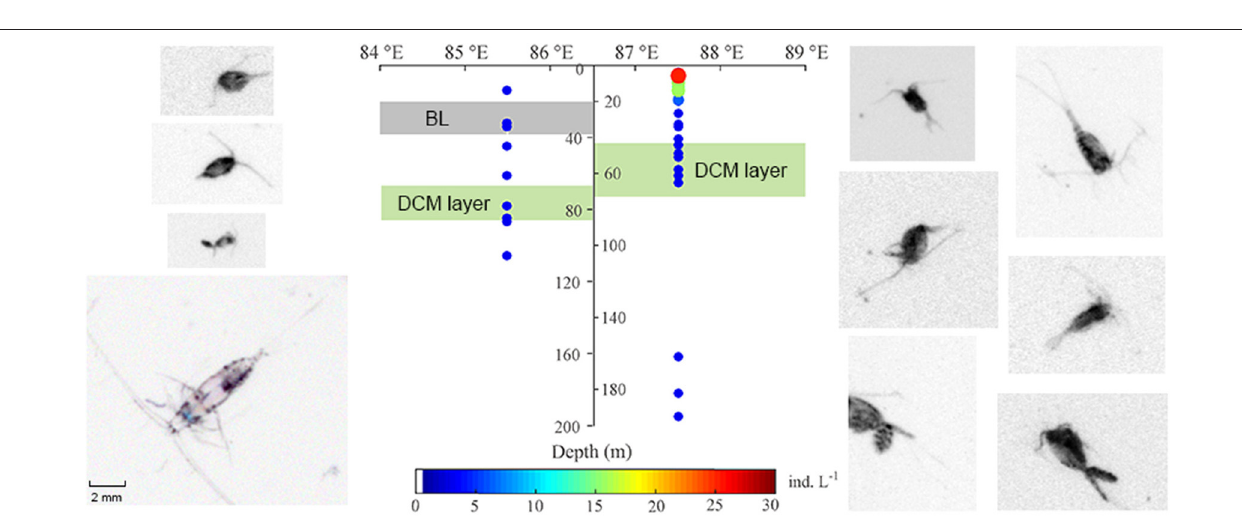
C ind. − 1 at station S7. Figure 6 depicts the vertical distribution of detrital particles and carbon concentrations at both